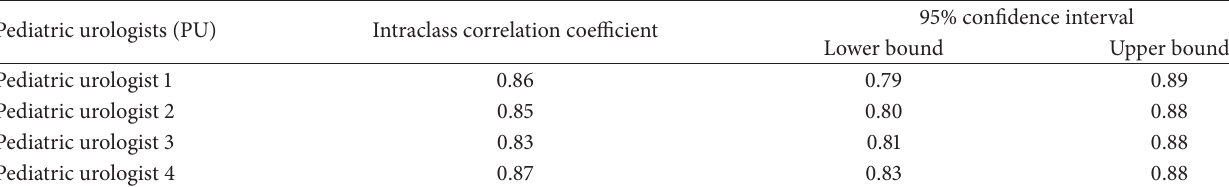
Table 1: Assessment of VUR grading among pediatric urologists.